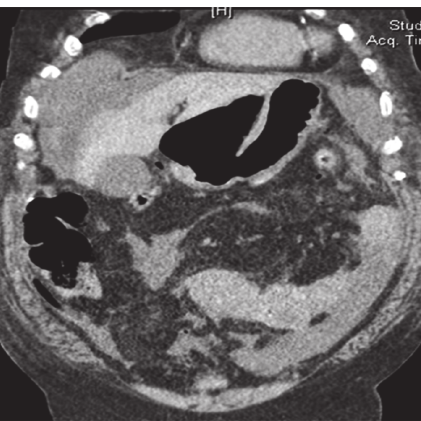
Figure 1: Computed tomography scan of abdomen showing discon- tinuity of the anterior wall of the gastric antrum with pneumoperi- toneum.